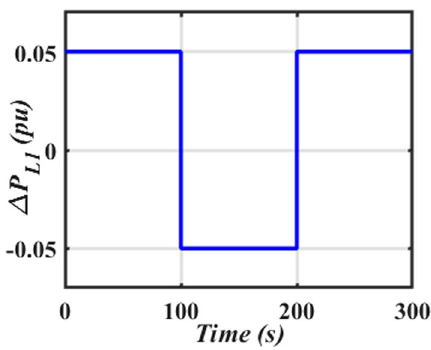
Fig. 11 Variable step load change in Area 1